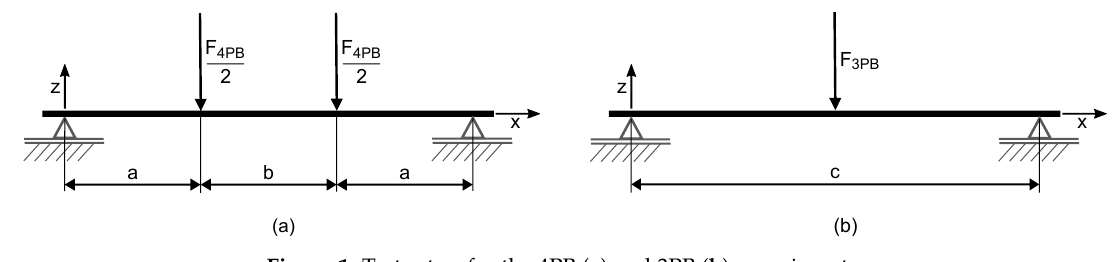
Figure 1. Test setup for the 4PB ( a ) and 3PB ( b ) experiments.